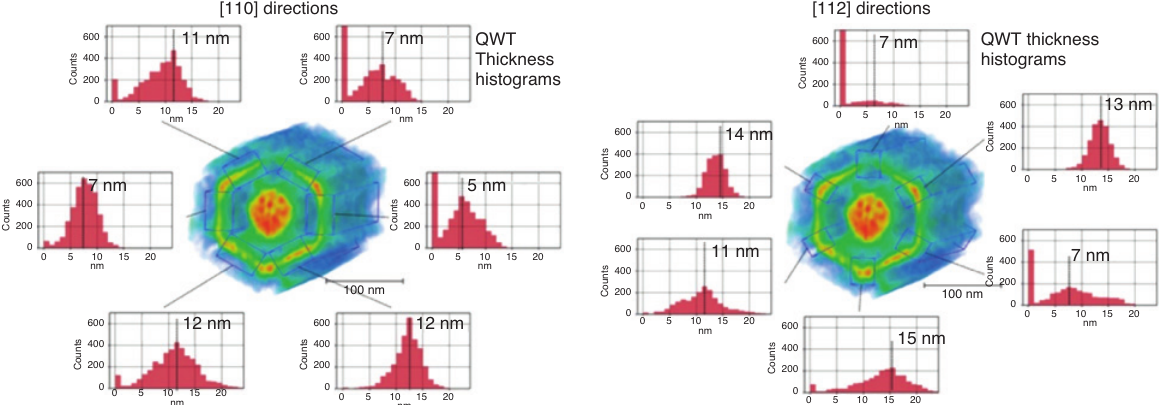
Figure 6: Analysis of the QWT thickness distribution of a trunk section of the GaAs-AlGaAs core-multishell nanowire in Figure 4 along the [110] and [112]